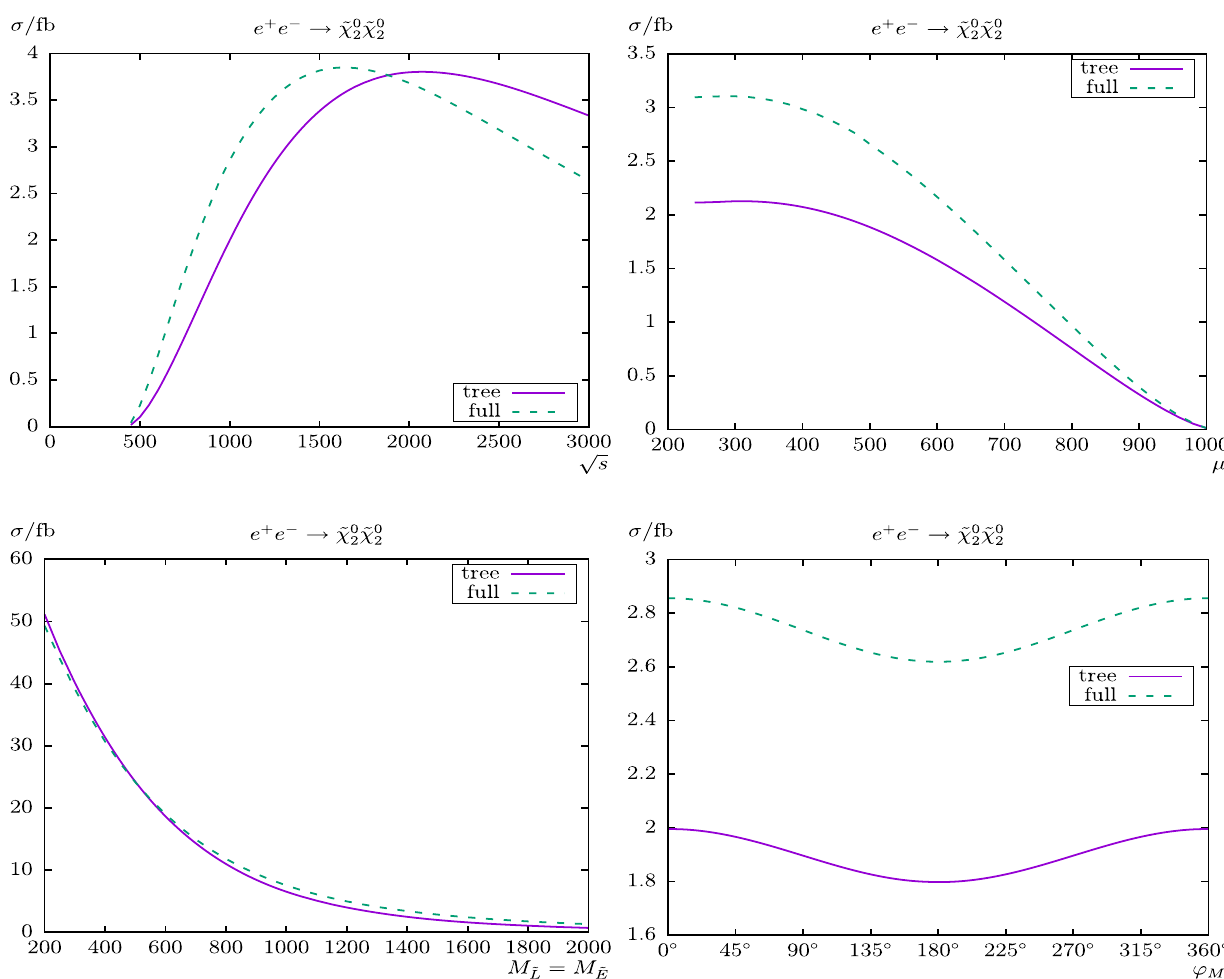
˜ χ 0 ) . Tree-level and full one-loop corrected cross sections are shown with parameters chosen according to S ; see Table 2. √ 2 2 s (left) and μ (right) varied; the lower plots show M ˜